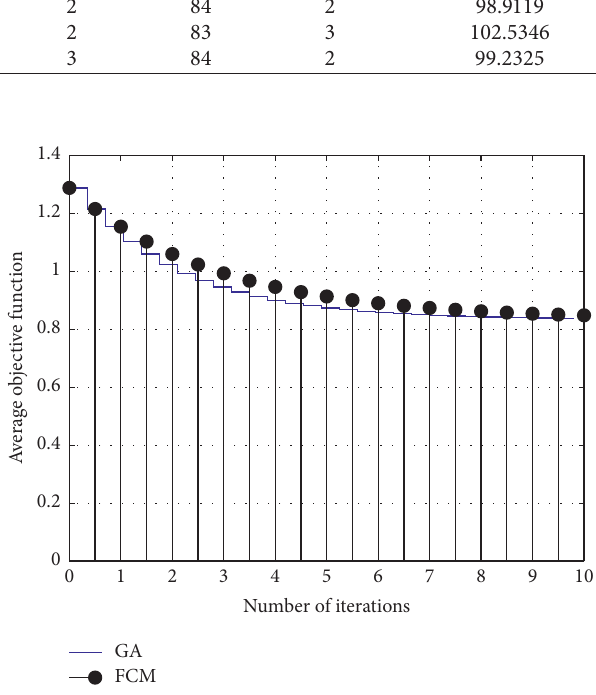
Figure 6: Comparison of the relationship between objective function and evolutionary